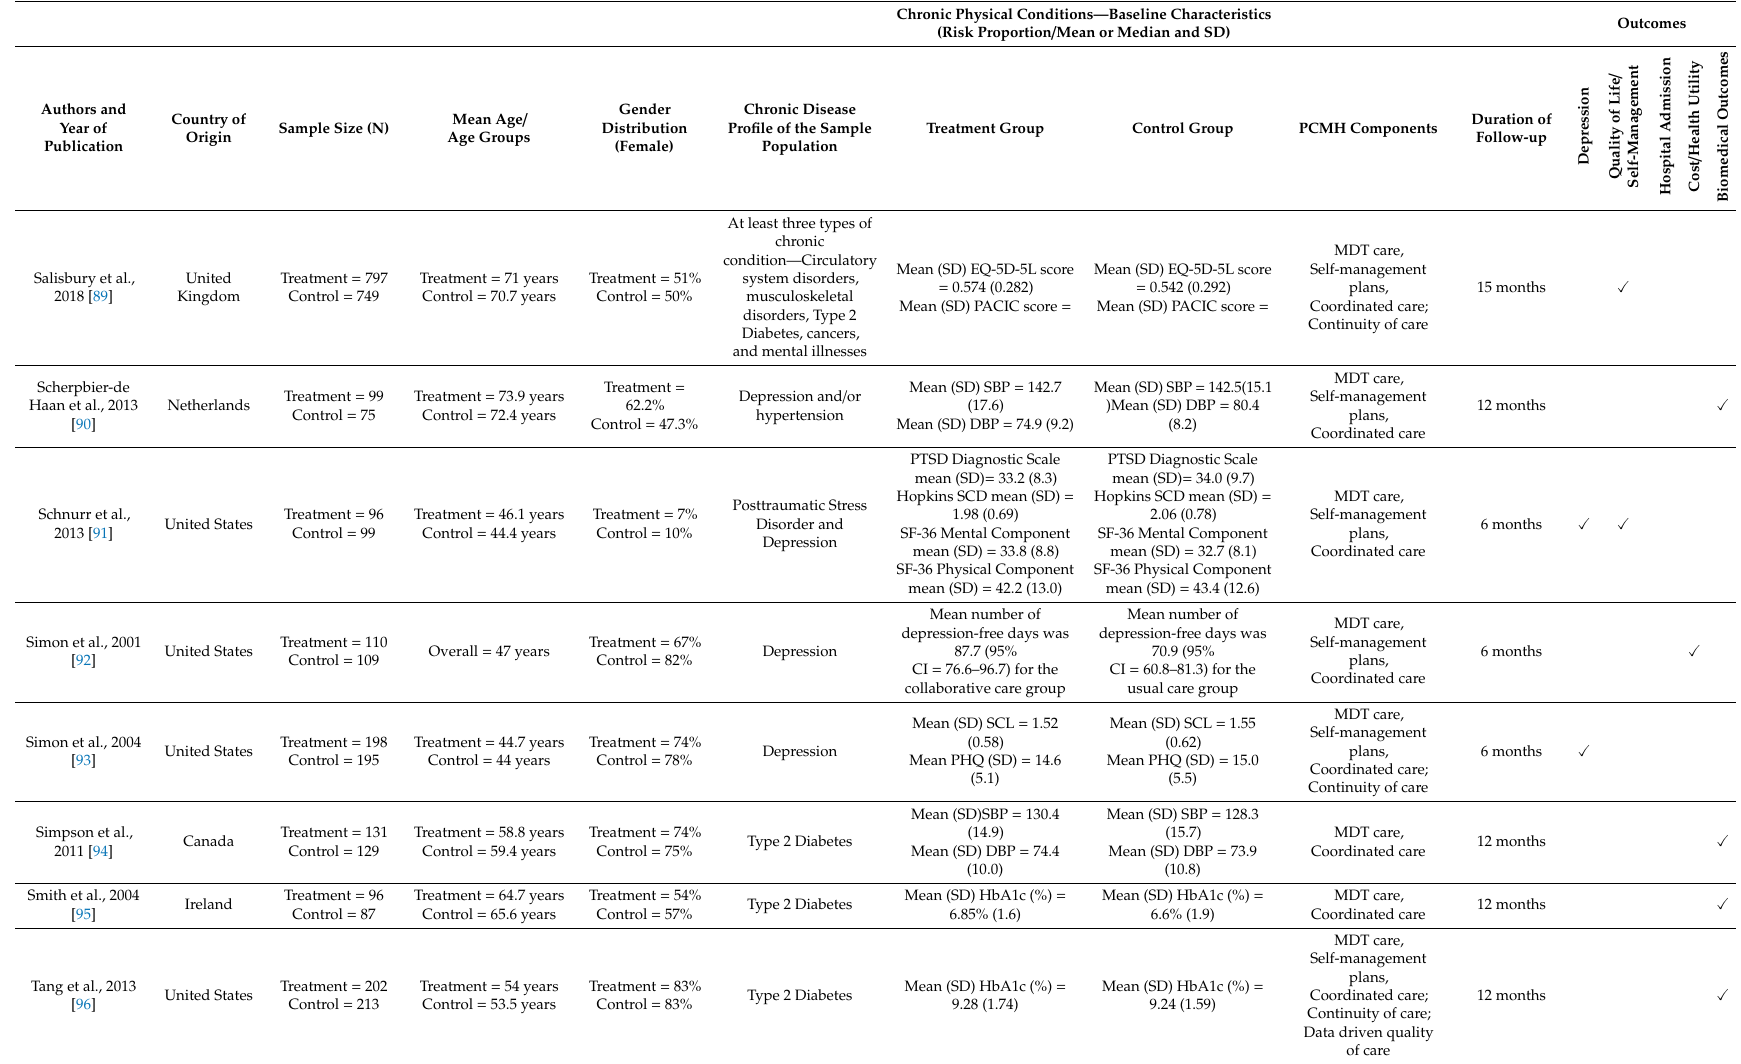
Table A3. Cont. Chronic Physical Conditions—Baseline Characteristics (Risk Proportion / Mean or Median and SD)